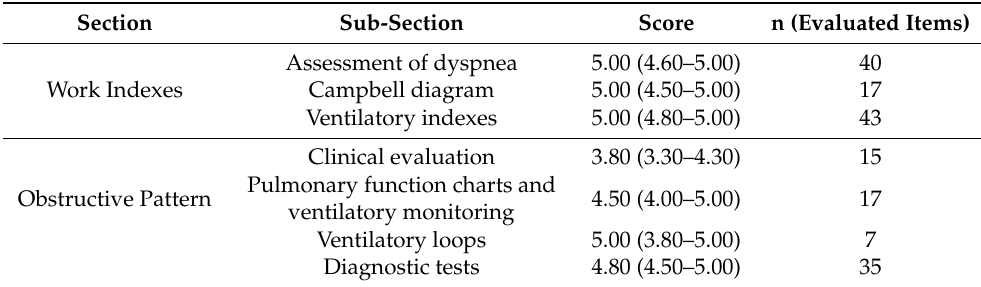
Table 8. Delphi validation results of the “Work of Breathing Indexes” module, organized by modules and sub-modules and scored from 1 to